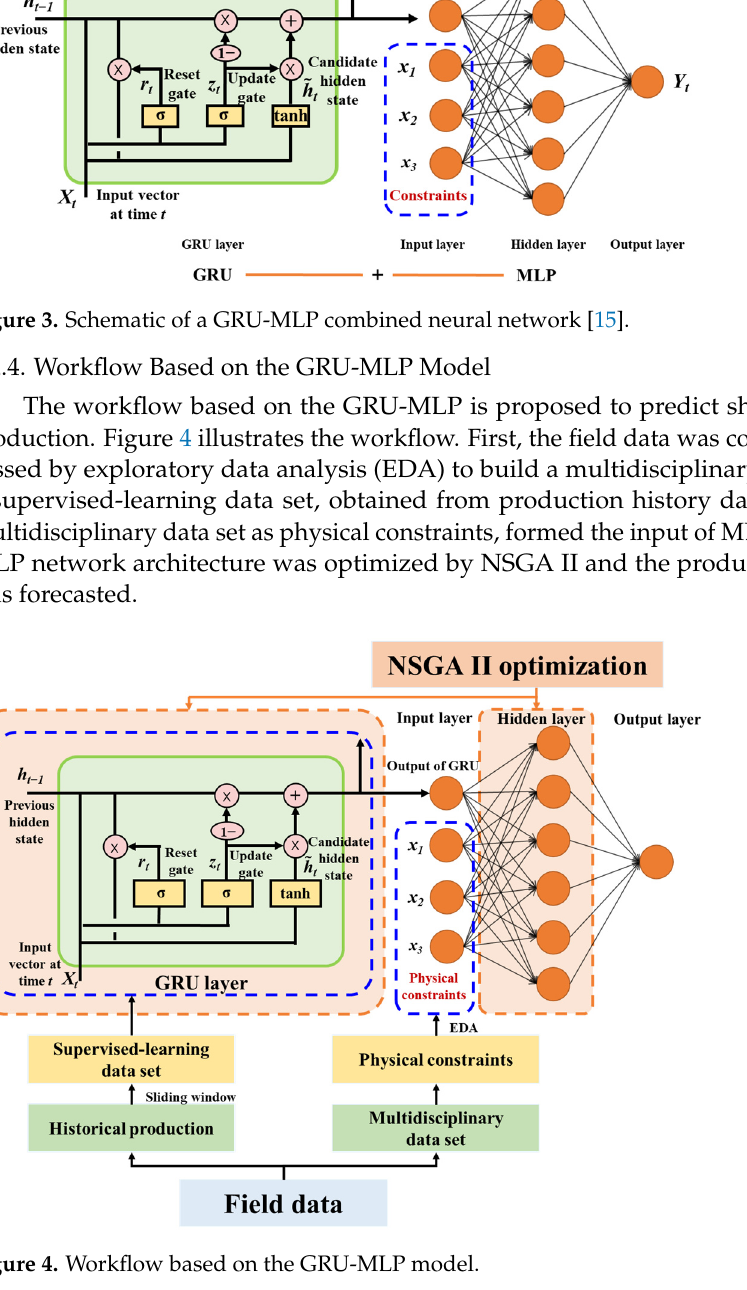
Figure 4. Workflow based on the GRU-MLP model.